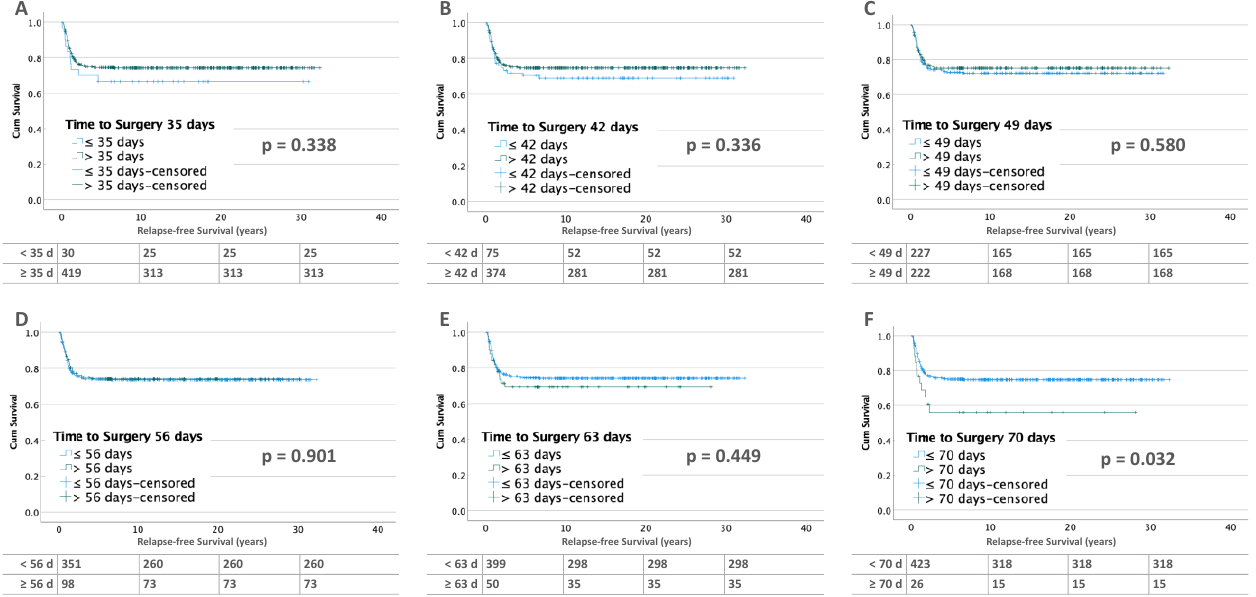
Figure 3. Kaplan–Meier lifetables of RFS of unilateral WT with metastases at diagnosis at thresholds of 35 ( A ), 42 ( B ), 49 ( C ), 56 ( D ), 63 ( E ) and 70 ( F ) days of preoperative chemotherapy. In the tables below the figures, the numbers at risk are